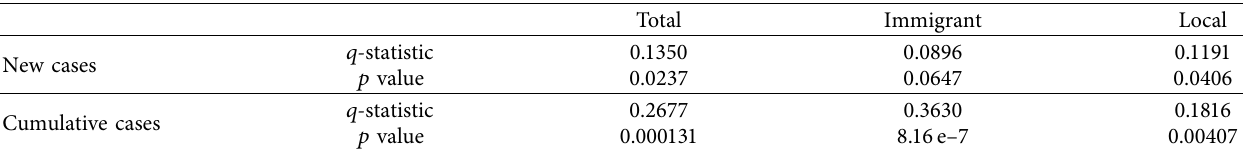
Table 6: The q -statistic and corresponding p value for the SSH